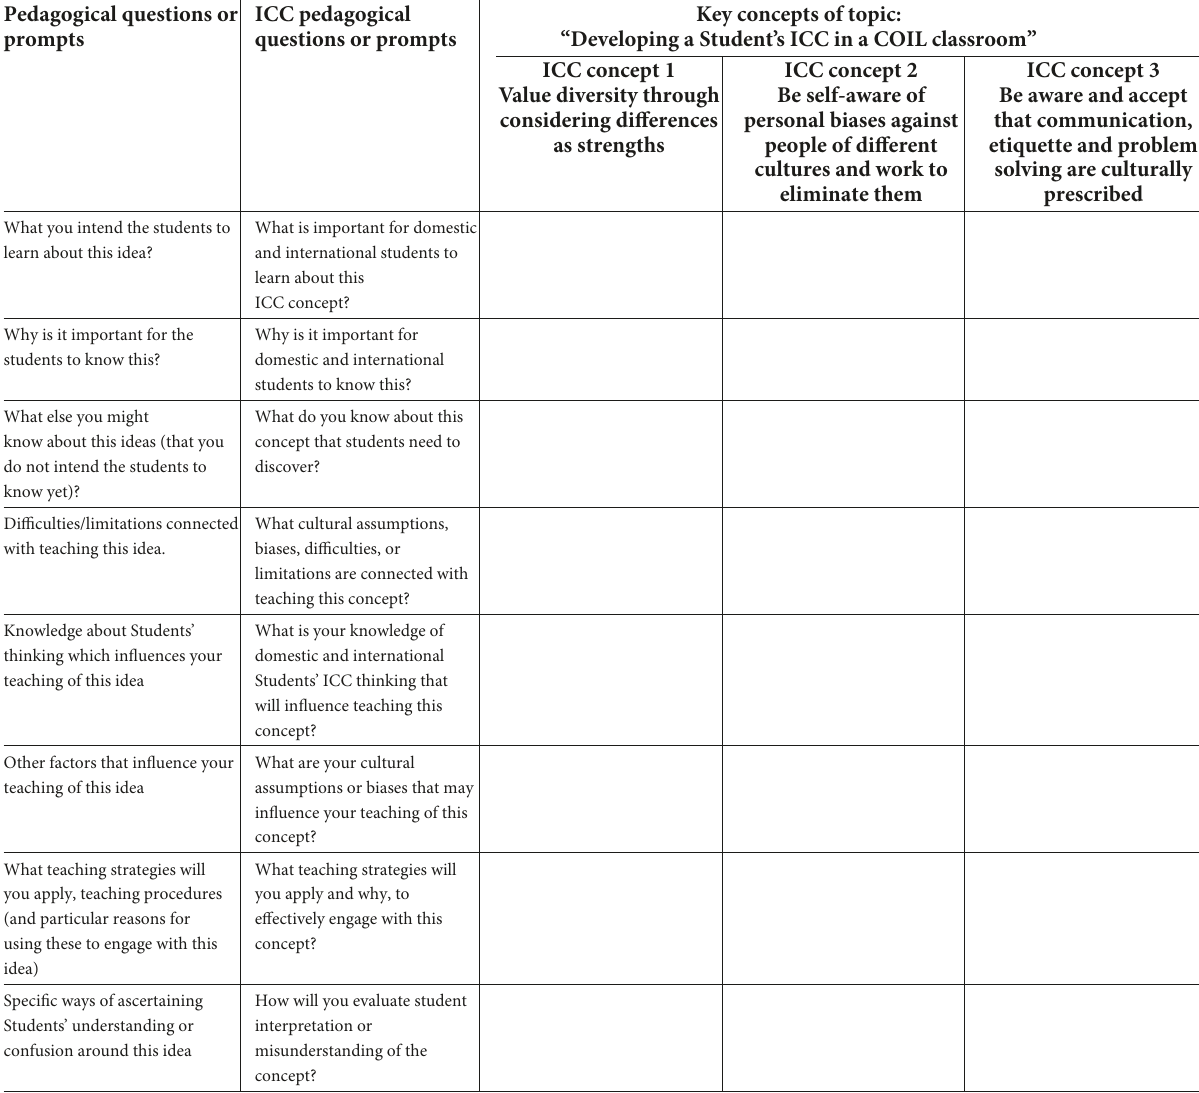
TABLE 1 Content representation (CoRe) matrix to assist educators develop their PCK in ICC, adapted from Loughran et al. (2004, 2008) and Hume (2010, 2013). Pedagogical questions or